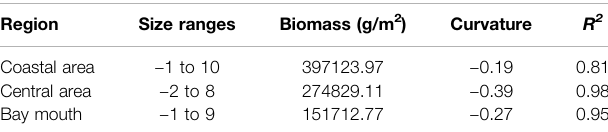
TABLE 3 | Spatial changes of the normalized biomass particle size spectrum of fi sh in Daya Bay. Region Size ranges Biomass (g/m 2